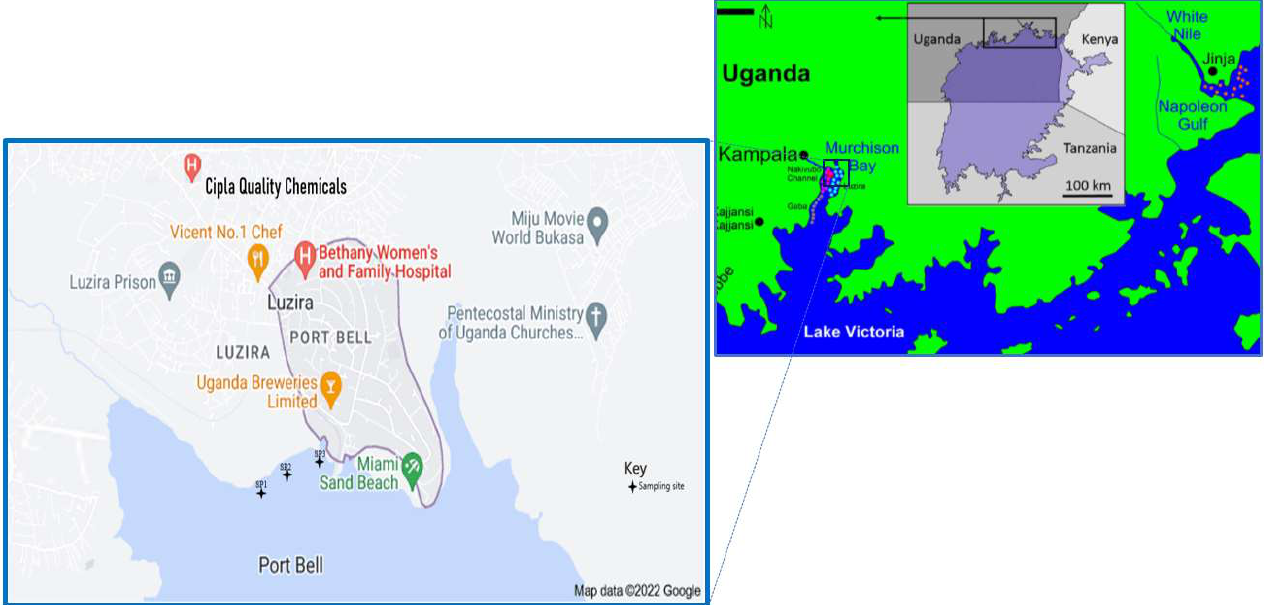
Figure 2. Map of Port Bell, L. Victoria, Uganda showing the location of the sampling sites (SP1 to SP3).